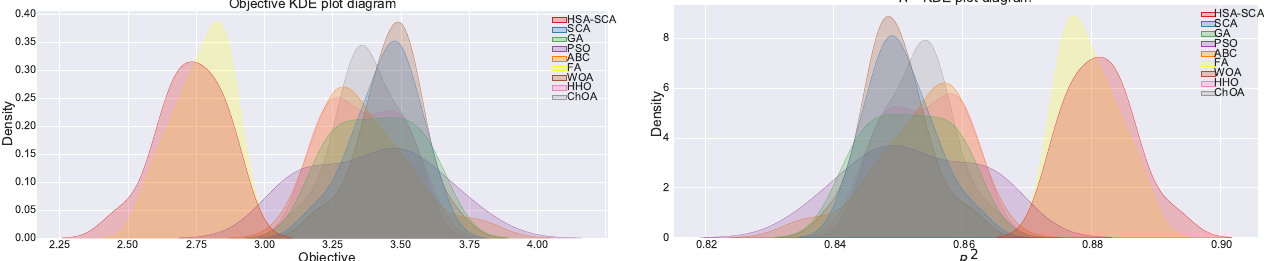
Figure 4 depicts the kernel density estimation (KDE), representing the estimation of the probability density function. It can be noted from these plots that the results originate from the normal distribution. Additionally, join plots of both fitness function (MSE) and R2 containing histograms for the two best algorithms (HSA-SCA and FA) are shown in Figure 5.